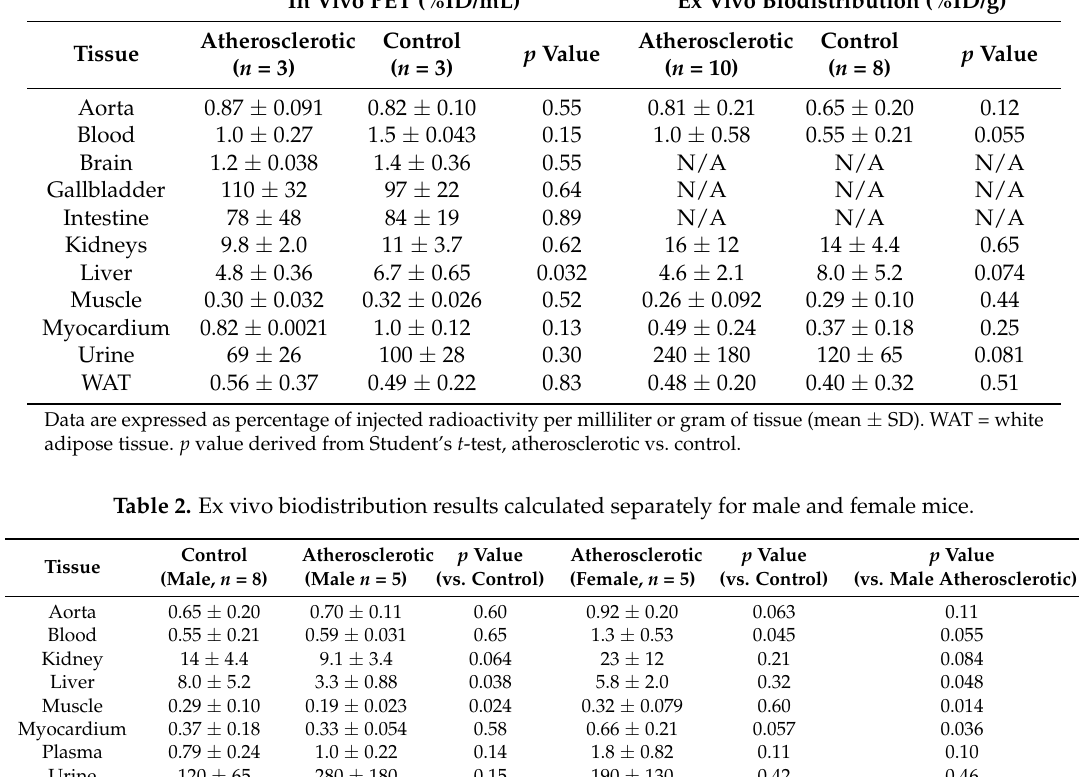
Table 1. The in vivo and ex vivo biodistribution of [ 18 F]Flutemetamol in mice at 30 min post-injection. In Vivo PET (%ID/mL) Ex Vivo Biodistribution (%ID/g) Atherosclerotic Control Tissue ( n = 3)